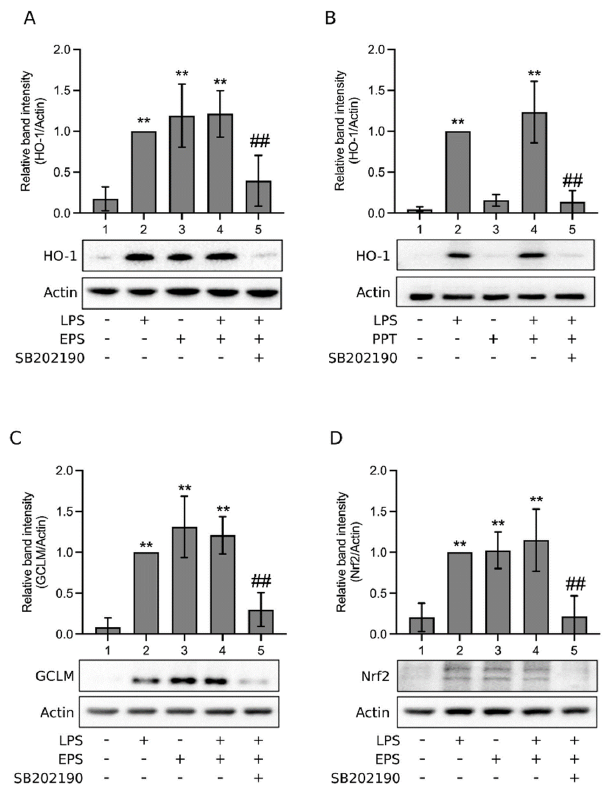
Figure 6. EPS activated the nuclear factor erythroid 2-related factor 2 (Nrf2)/heme oxygenase-1 (HO-1) pathway. ( A , C , D ) THP-1 cells were treated with vehicle (Lane 1), 1 µ g/mL LPS (Lane 2), 100 µ g/mL EPS (Lane 3), LPS and EPS (Lane 4), or LPS, EPS, and 20 µ M SB202190 (Lane 5) for 24 h. ( B ) the same experiment of ( A ) was performed, but EPS was replaced by PPT. The expression levels of HO-1 ( A , B ), the glutamate-cysteine ligase modifier subunit (GCLM; C ), and Nrf2 ( D ) in the cells were assayed using Western blotting. Relative band intensity vs. Lane 2 was determined. Data are presented as the mean ± standard deviation of four independent experiments. ** p < 0.005 vs. Lane 1; ## p < 0.005 vs. Lane